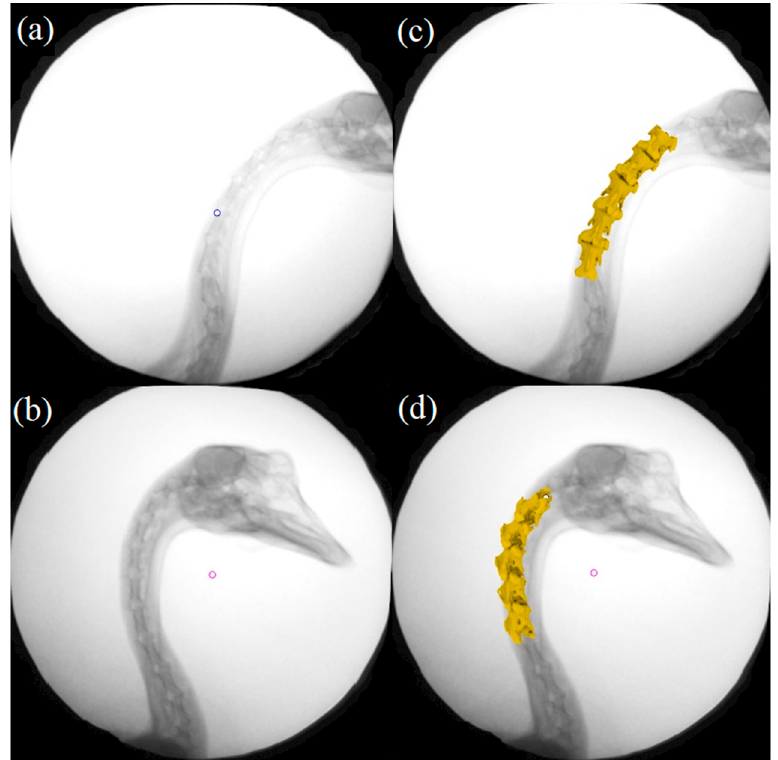
Figure 4. Relationship between model and radiograph positions before and after alignment: ( a , b ) X-ray images before alignment, ( c , d ) X-ray images after alignment.